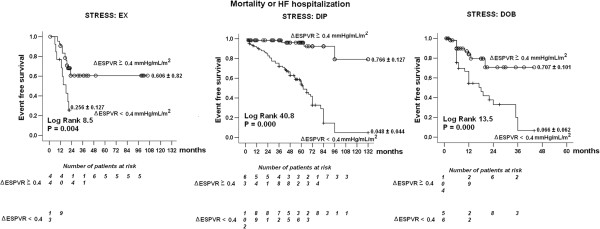
Survival in patients with negative stress echo according to the employed stress. Kaplan-Meier survival curves (considering combined death or HF hospitalization as an endpoint) in medically treated patients stratified according to the presence of stress end-systolic pressure-volume relation-based contractile reserve (ΔESPVR ≥ 0.4 mmHg/mL/m2 vs rest as cutoff value). Left panel, patients (n = 57) stratified according to exercise stress echo. Middle panel, patients (n = 165) stratified according to dipyridamole stress echo. Right panel, patients (n = 160) stratified according to dobutamine stress echo.